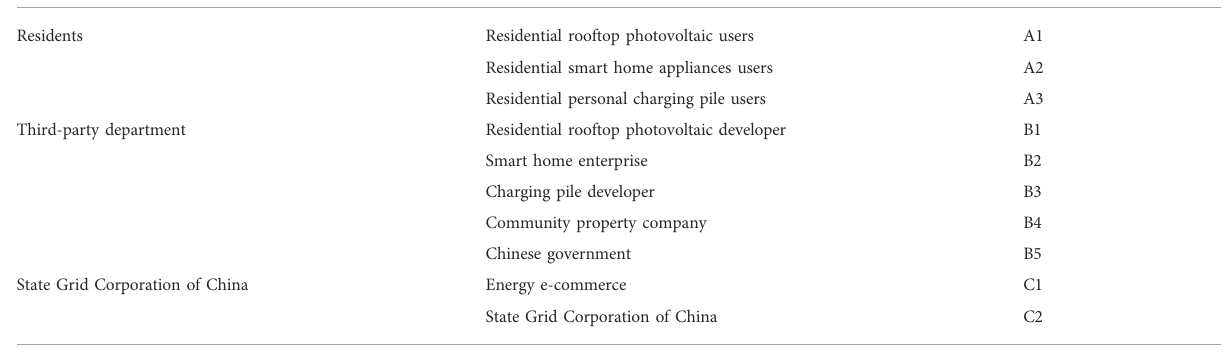
TABLE 10 Centrality table of each node. Node Centrality Structural hole Degree centrality